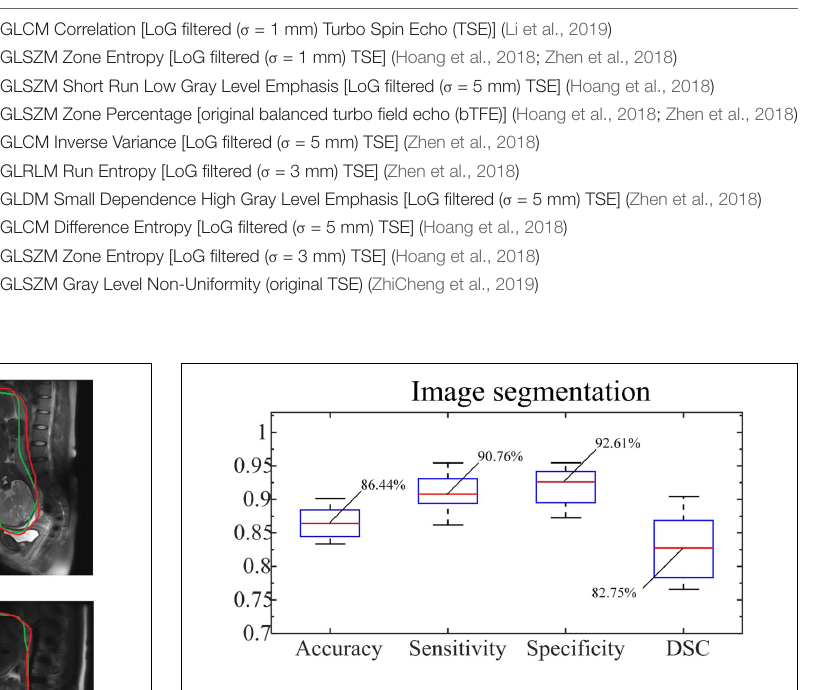
FIGURE 7 | Accuracy, sensitivity and specificity of segmentation and DSC. The number indicated is the